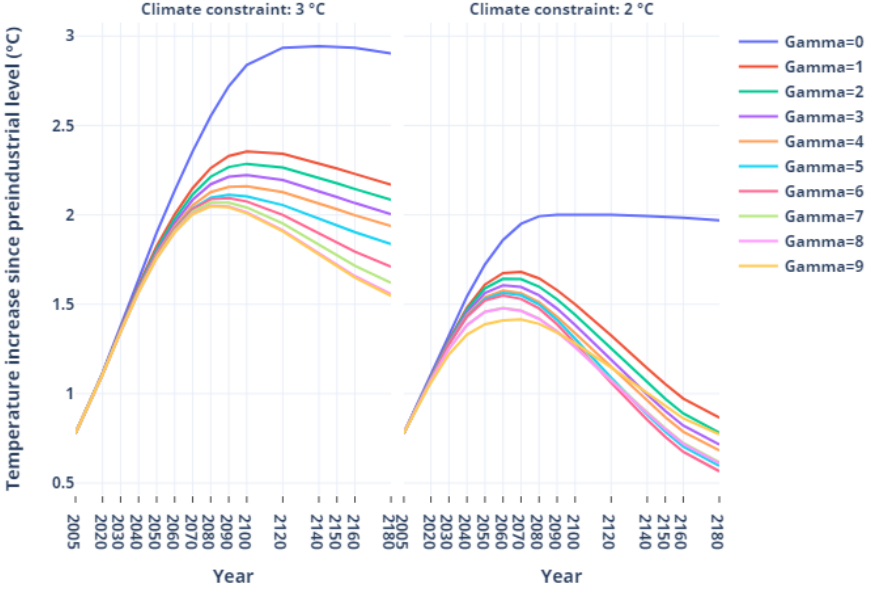
Figure 3. Atmospheric temperature trajectories for different values of the uncertainty